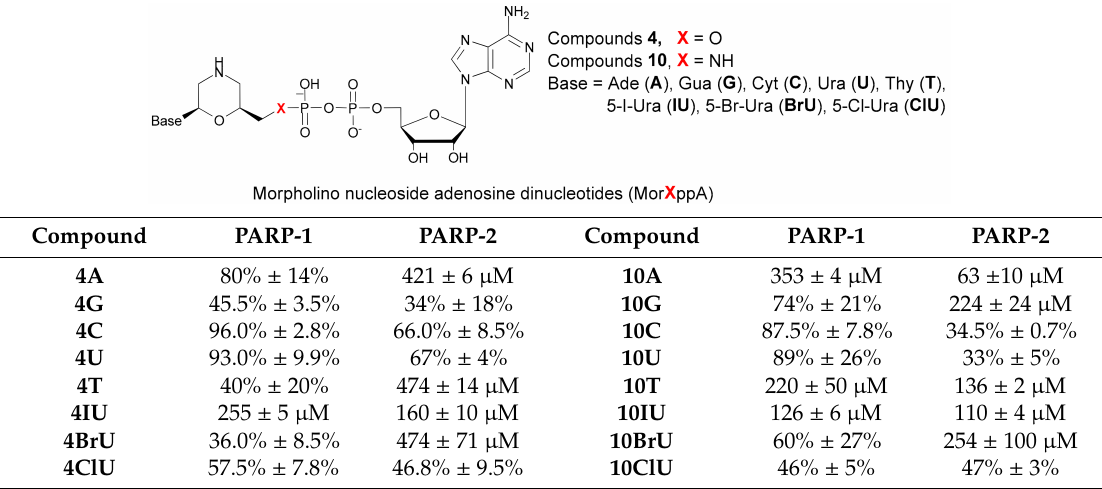
Table 1. Residual PARP-1 and PARP-2 activity (%) in the presence of 1 mM compounds 4 and 10 or IC 50 ( µ М )